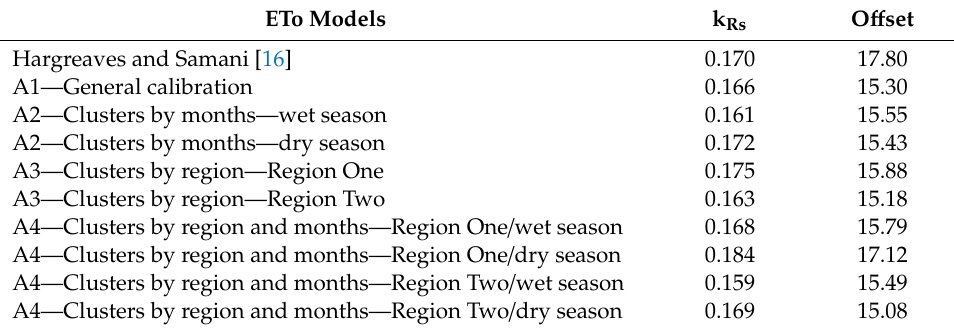
Table 2. Summary of coe ffi cients for Hargreaves–Samani equation calibration.